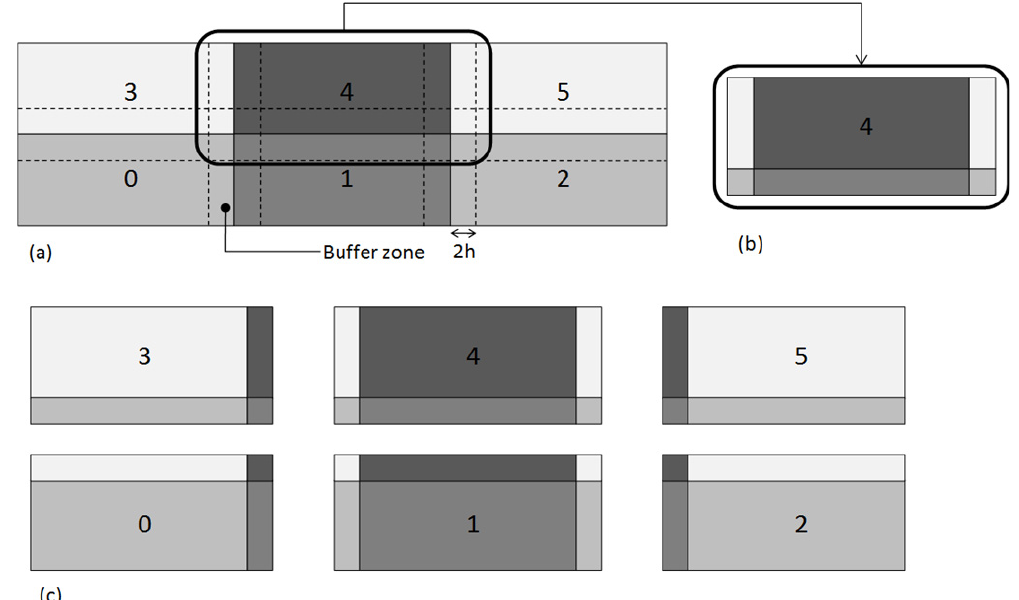
Fig. 4. Domain decomposition and buffer zones for data